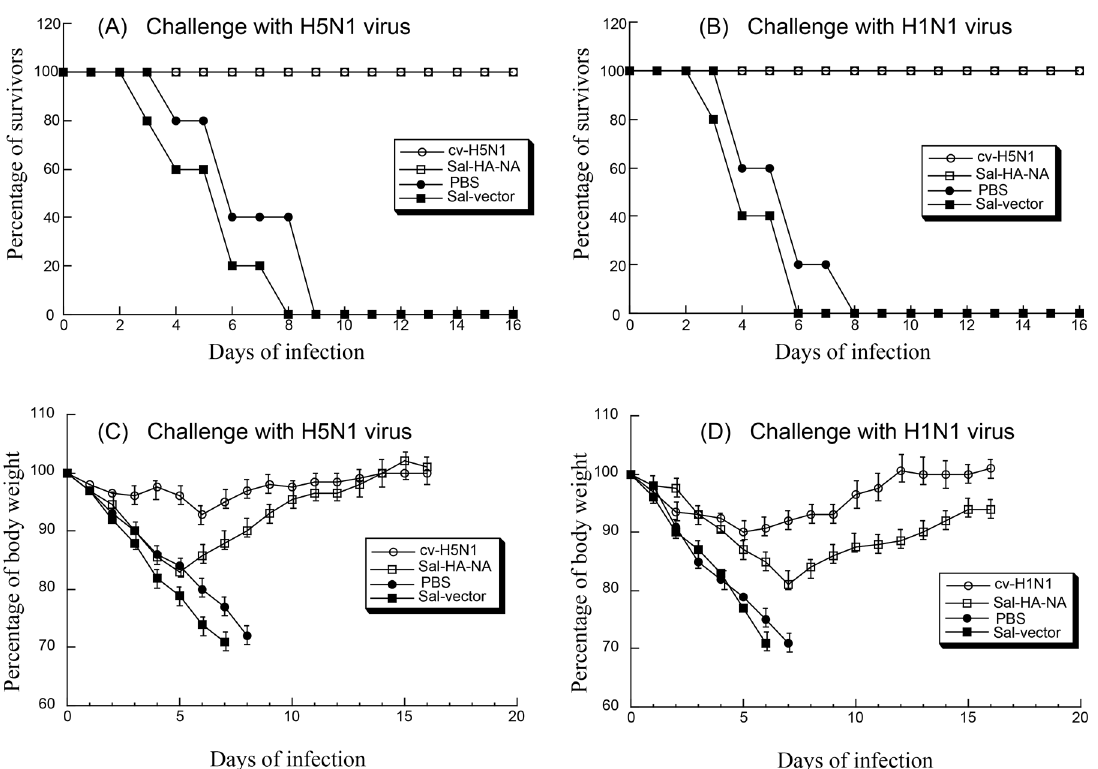
Fig 6. Immune protection of mice from lethal H5N1 (A and C) and H1N1 viral challenge (B and D). Groups of mice (n = 5) were intragastrically immunized three times at day 0, 14, and 28 with PBS only, the commercial H5N1 (cv-H5N1) and H1N1 vaccines (cv-H1N1), and Salmonella SL368 carrying the empty vector pVAX1 (Sal-vector) and constructs p5HA and p5NA (Sal-HA-NA), and then challenged intranasally with 20 LD 50 of lethal H5N1 (A/Viet Nam/1194R) and H1N1 (A/Puerto Rico/8/34) viruses at two weeks after final immunization (i.e. at 42 days post initial immunization). Mice were monitored for survival (A and B) and weight loss (C and D) throughout a 16 day observation period. The results are presented in terms of percent survival and percent of body weight (at the beginning of the trial) respectively. Humane (non-lethal) endpoints were used during the survival experiments and mice were euthanized with overdose inhalational CO 2 when they exhibited weight loss of more than 30%, lethargy, ruffled hair coat, or hunched